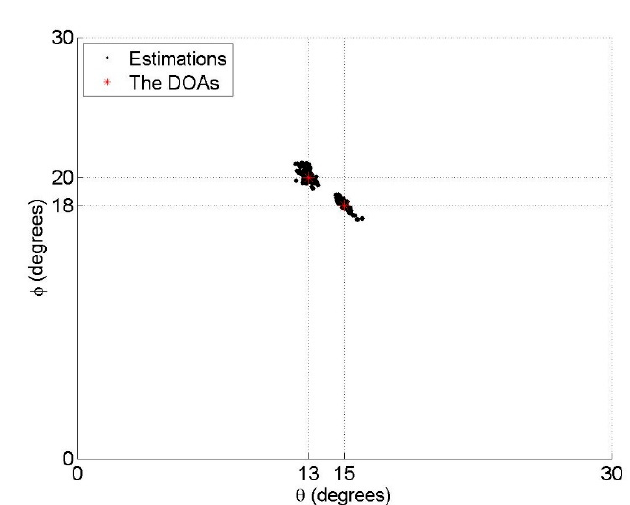
Figure 5. Estimation results of the proposed method, where 100 Monte Carlo trials are carried out.